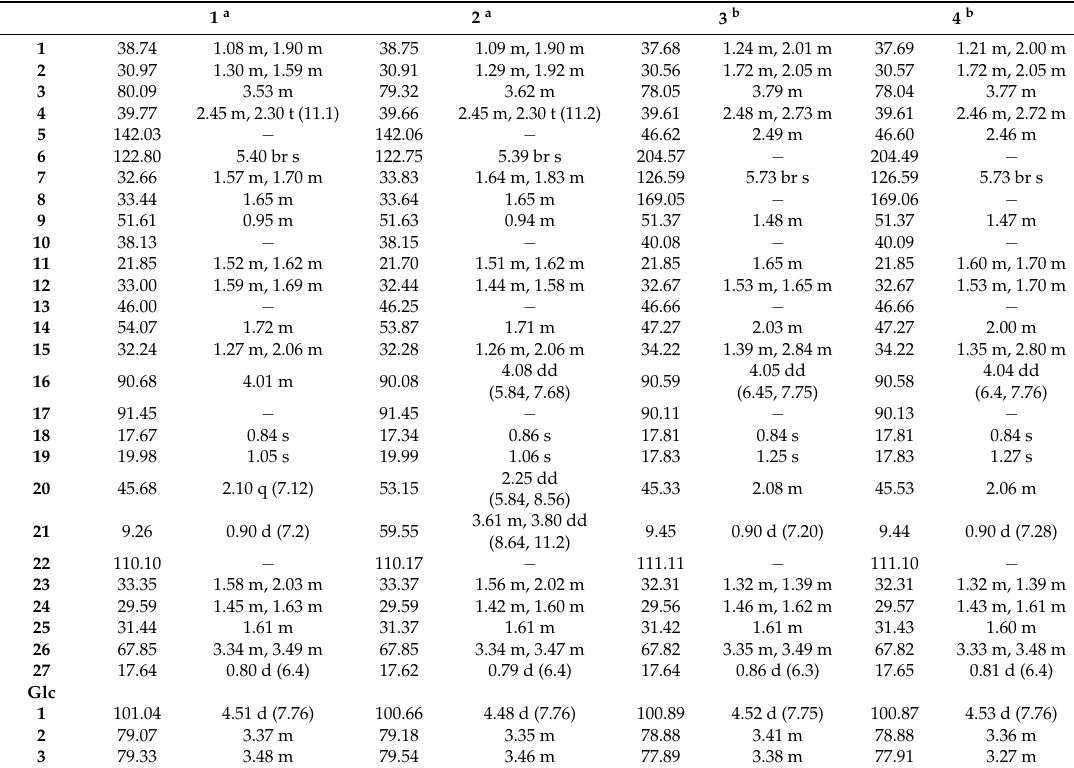
Table 1. 1 H- and 13 C-NMR data for Compounds 1–4 in CD 3 OD †